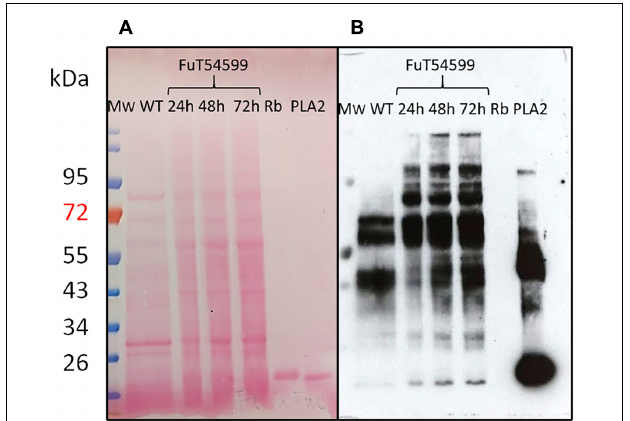
FIGURE 7 | N -glycans bearing the α (1,3)-fucose epitope are increasing in P. tricornutum cells expressing the Golgi resident V5-tagged FuT54599. Western Blot analysis of total protein extracts from WT (lane 1) and P. tricornutum cells expressing the V5-tagged FuT54599 using a specific core α (1,3)-fucose antibody. Total proteins have been extracted from P. tricornutum cells expressing the V5-tagged FuT54599 24 h after induction (lane 2); 48 h after induction (lane 3); 72 h after induction (lane 4). The 15 kDa Ribonuclease B (Rb) was used a negative control (lane 5) and the 14.5 kDa Phospholipase A2 (PLA2) was used as a positive control (lane 6). In parallel, molecular weight (Mw) markers (PageRuler Plus Prestained Protein Ladder, Thermo Fisher) are reported and expressed in kDa. (A) Ponceau red staining of the membrane. (B) Revelation with the anti- α (1,3)-fucose antibody